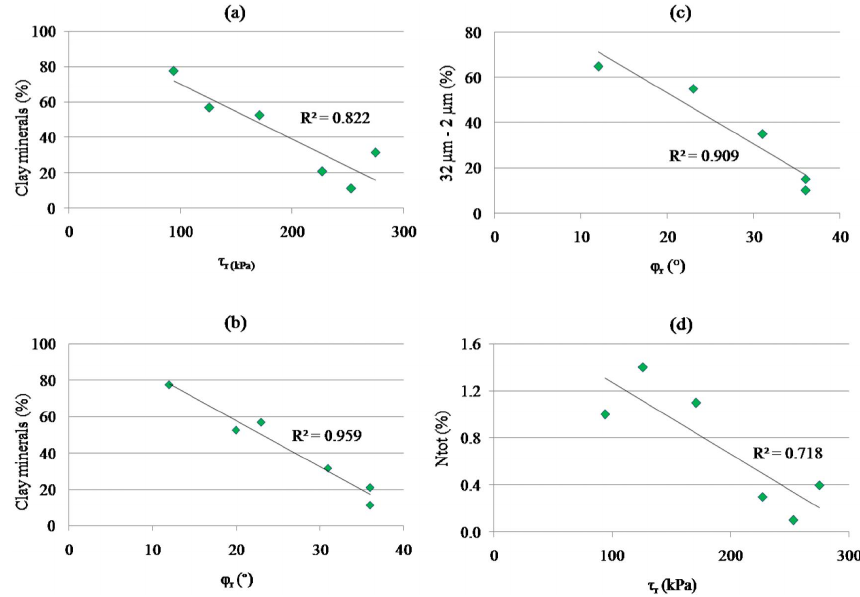
Figure 13. Correlations between residual friction angle ( ϕ r ), residual shear strength ( τ r ) and some compositional characters.